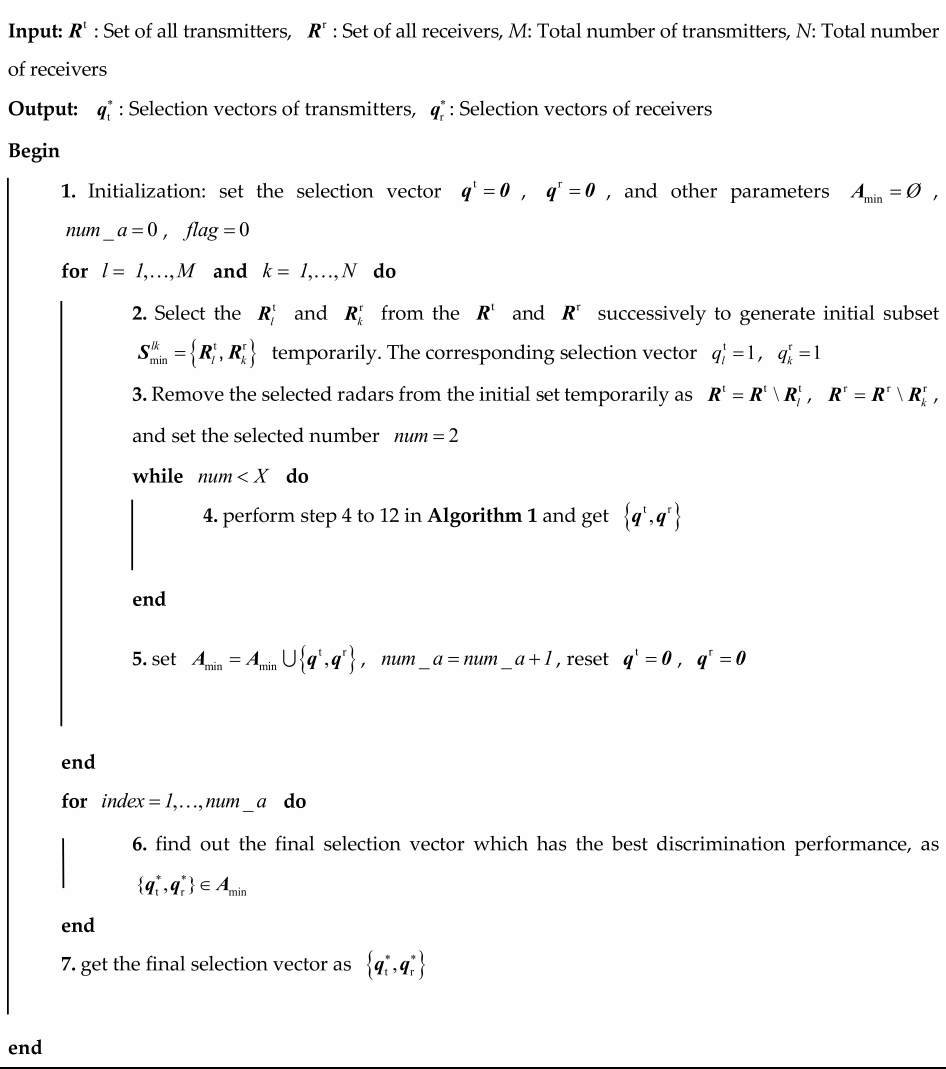
Algorithm 3: Algorithm of Selection Strategy for Predetermined